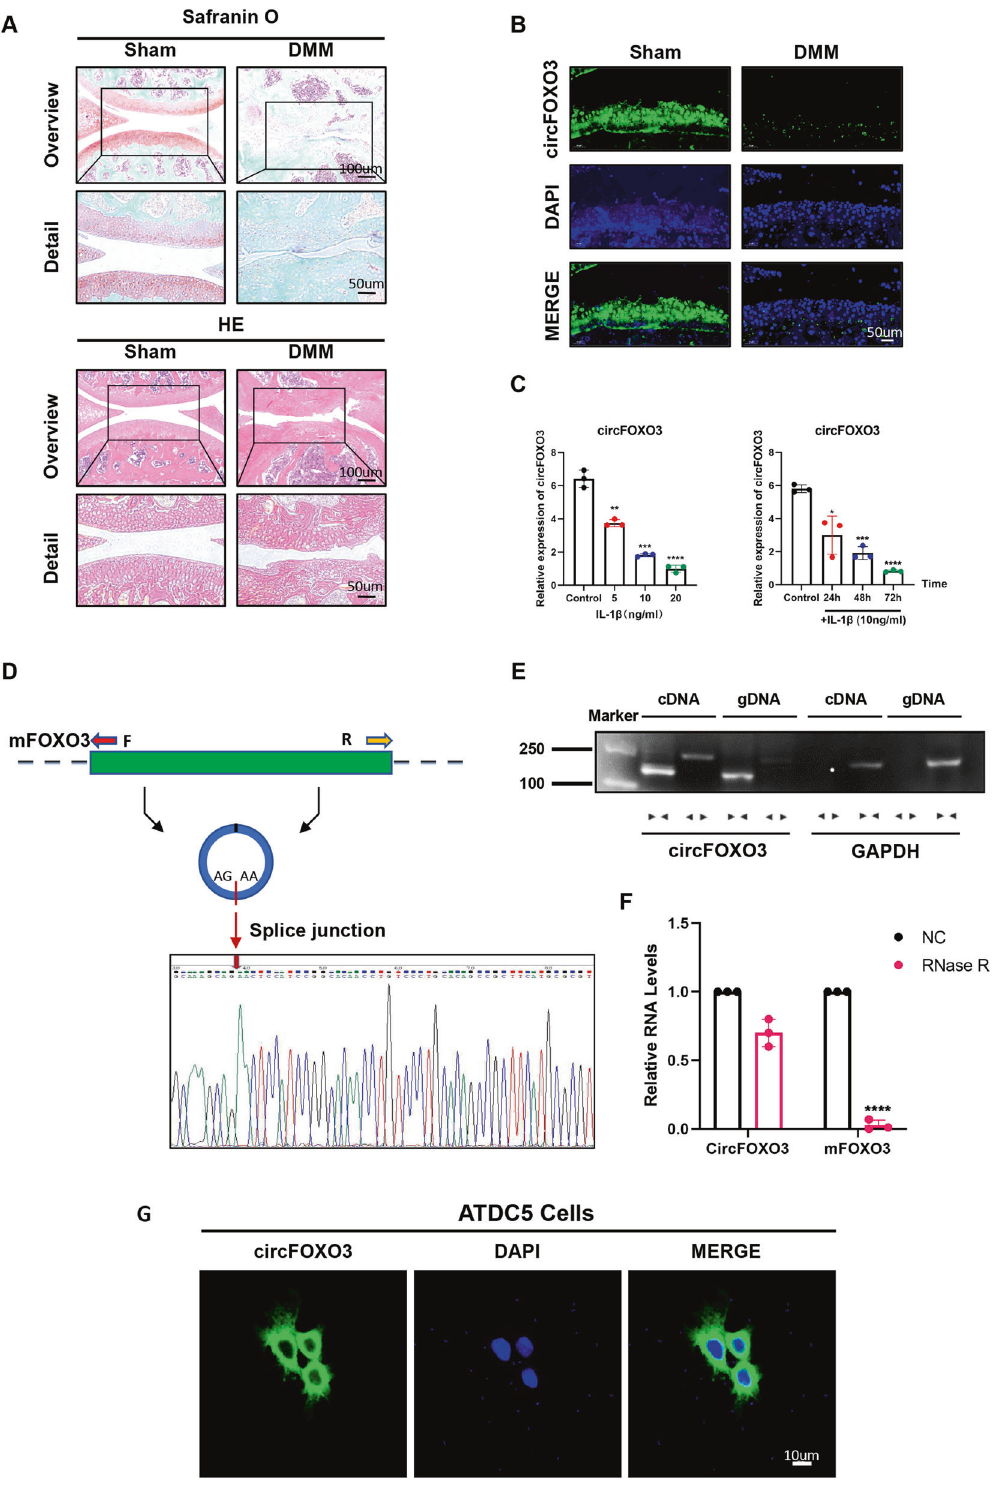
Fig. 1 CircFOXO3 exhibits lower expression in OA tissue and predominantly localized in the cytoplasm. A Safranin-O/fast green staining and H&E staining of the cartilage from different groups. Scale bars, 100 µm and 50 µm. B Expression levels of circFOXO3 was detected by RNA FISH in C57BL/6 samples. Representative photomicrographs and fl uorescence intensity of FISH are shown. Scale bar, 50 µm. C Expression of circFOXO3 after treating with IL-1 β for different concentrations and time spans. ( n = 3) * p < 0.05, ** p < 0.01, *** p < 0.001, **** p < 0.0001. D Sanger sequencing after PCR using the indicated divergent fl anking primers con fi rmed the “ head-to-tail ” splicing of circFOXO3. E The presence of circFOXO3 was validated in ATDC5s, circFOXO3 was ampli fi ed by divergent primers in cDNA but not gDNA. GAPDH was used as a negative control. F After treating or without treating with RNase R, the expression of circFOXO3 and FOXO3 mRNA in ATDC5s were detected by RT-qPCR. ( n = 3) **** p < 0.0001. G RNA FISH showed that circFOXO3 was predominantly localized in the cytoplasm. CircFOXO3 probes were labeled with Cy-3. The nuclei were stained with DAPI. Scale bar, 10 µm. Cell Death and Disease (2022)